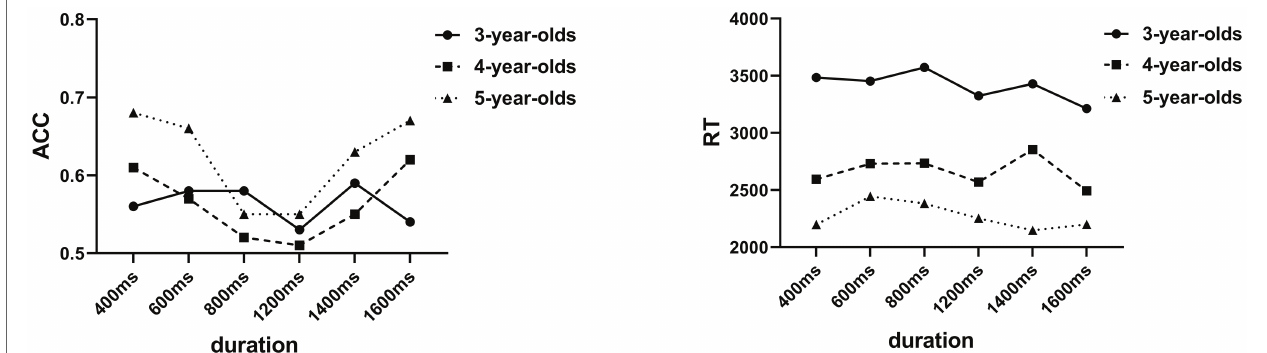
FIGURE 2 | Children’s performance on time perception task (accuracy, ACC and reaction time,